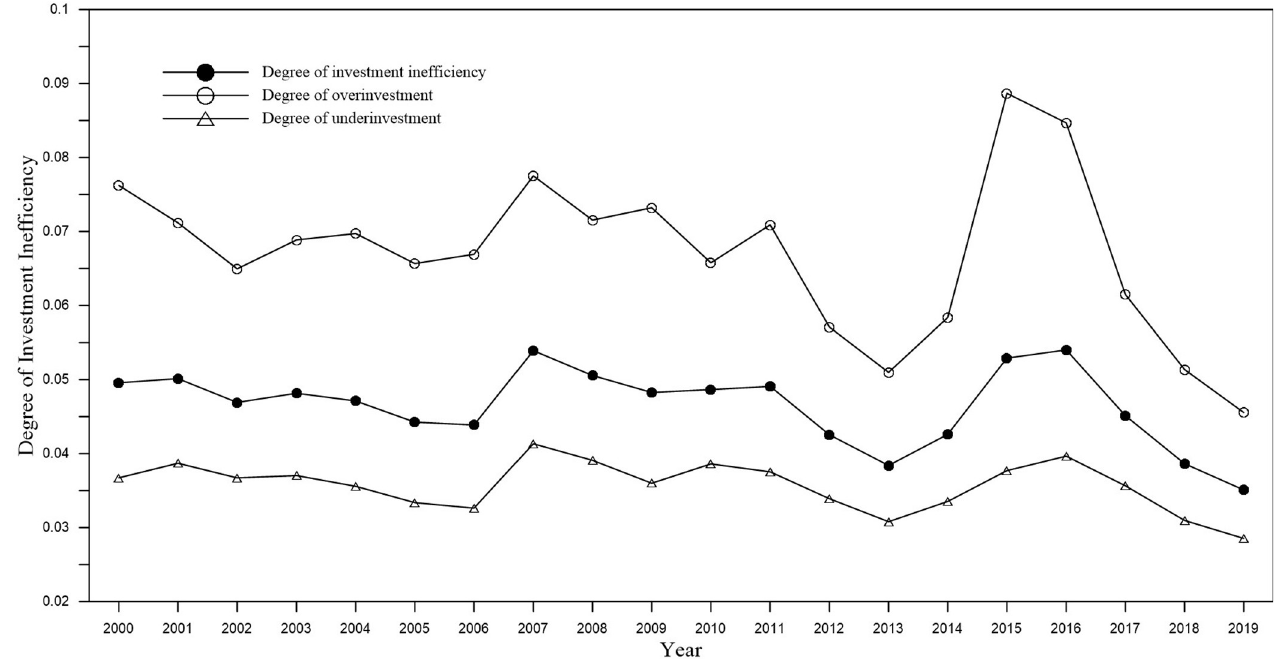
Fig 2. Trend of investment